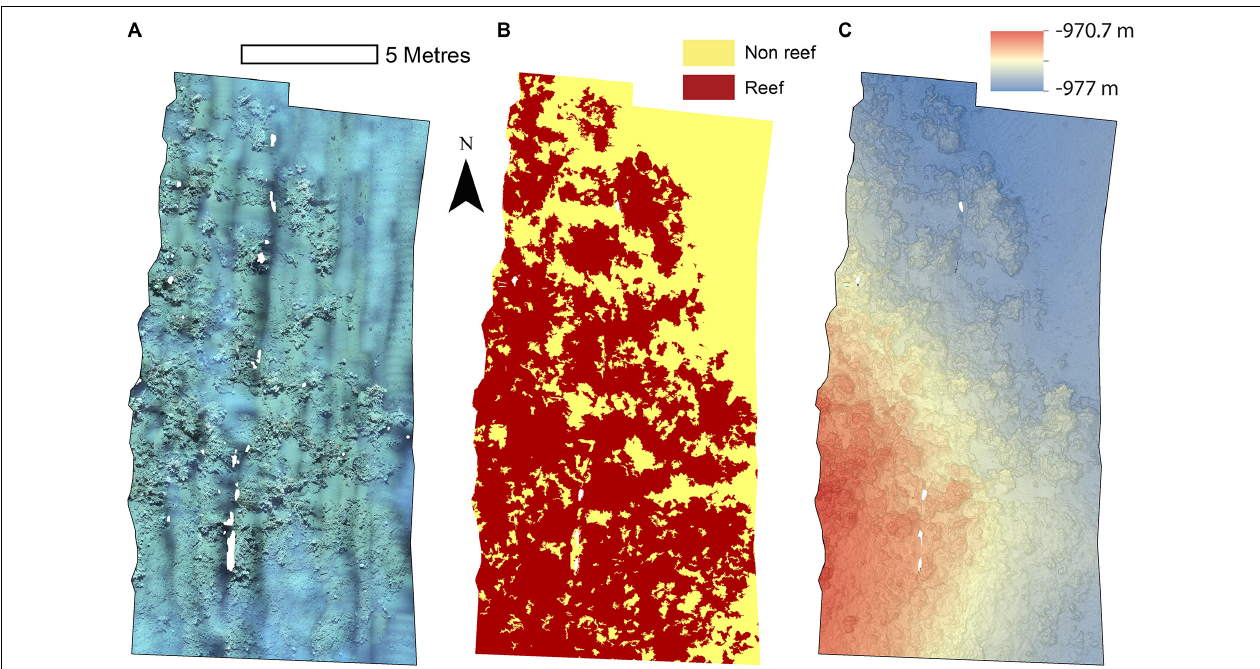
FIGURE 2 | Mosaics of Site A. (A) Orthorectified photomosaic; (B) Classified substrate map; (C) Digital elevation